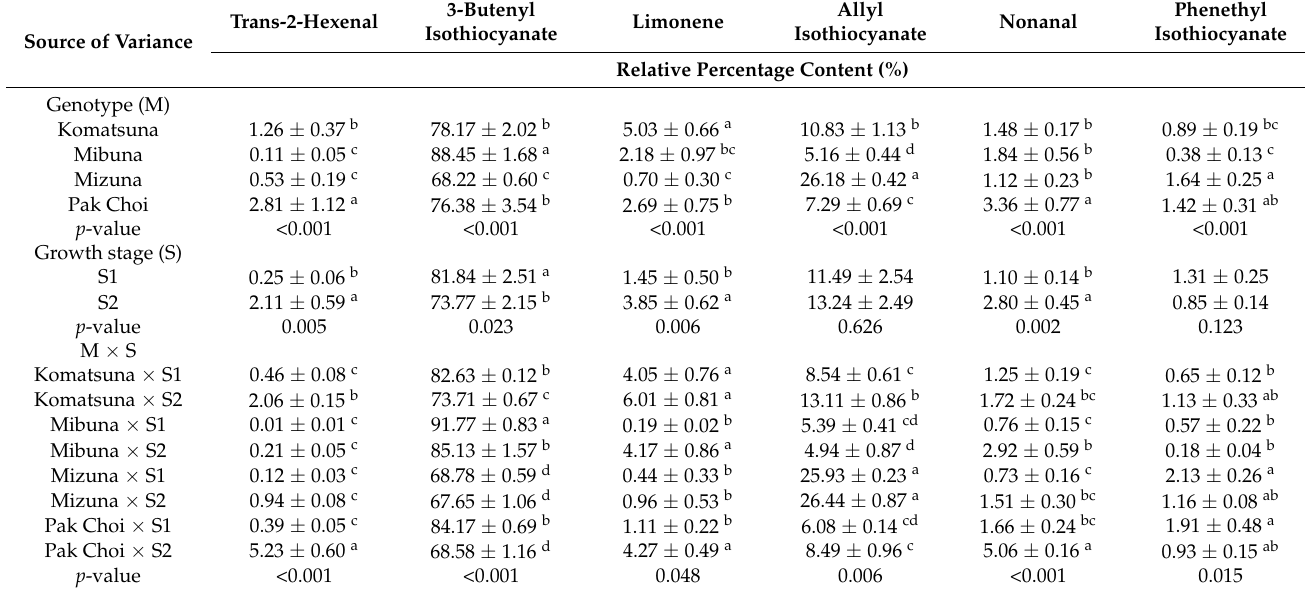
Table 4. Volatile Organic Compounds (VOCs) content of four Brassica rapa L. microgreens harvested at the first (S1) or second true-leaf stage (S2). All data are expressed as mean ± standard error, n = 3. All data are expressed as mean ± standard error, n =